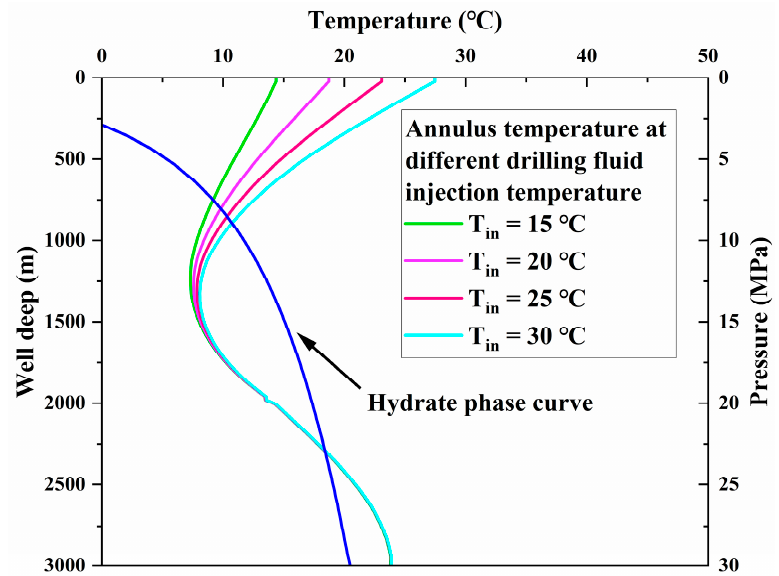
Figure 2. Risk of gas hydrate formation under different drilling fluid inlet temperatures.